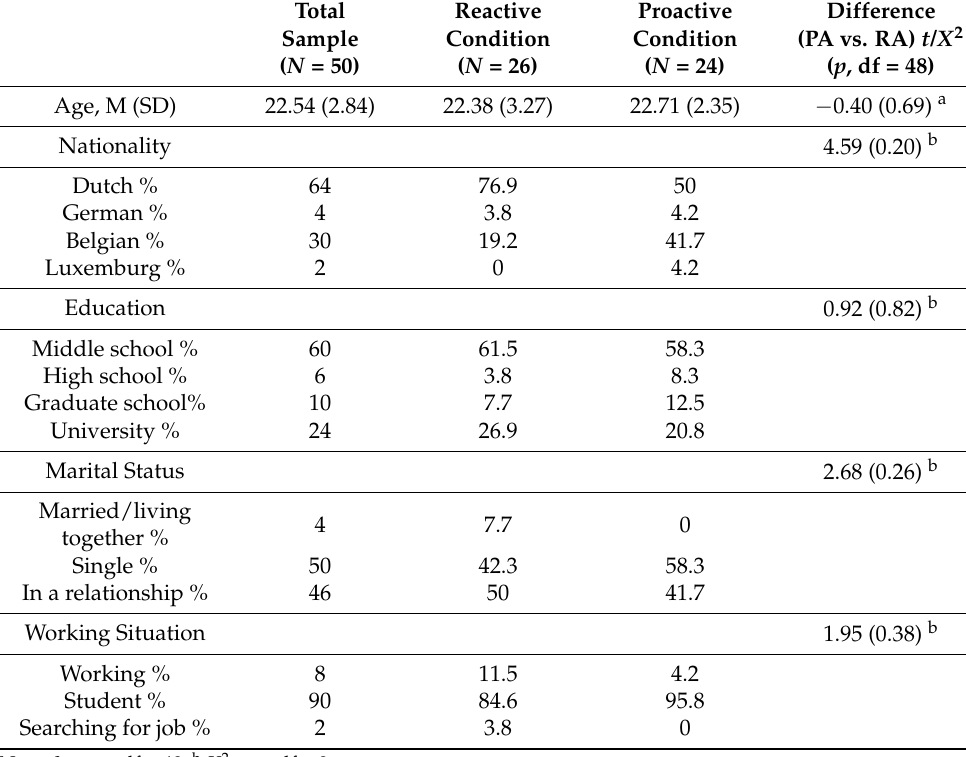
Table 3. Study 2: Biographical information of the total sample and split by condition.